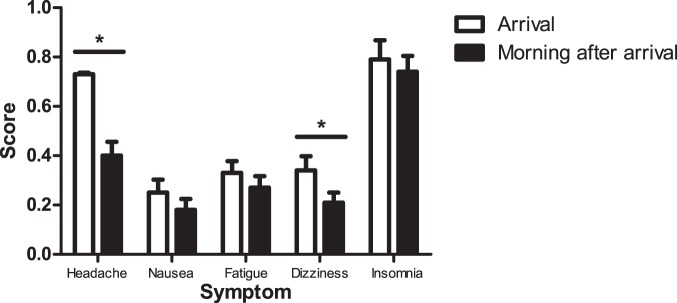
A comparison of the AMS symptoms of Nepalese pilgrims who were assessed upon arrival to, and on the morning after arrival to, Gosainkunda (n = 125).Headache and dizziness scores were significantly lower the morning after arrival (t = 4.46; p<0.001; t = 2.33; p = 0.02, respectively). Error bars represent one standard error of the mean.